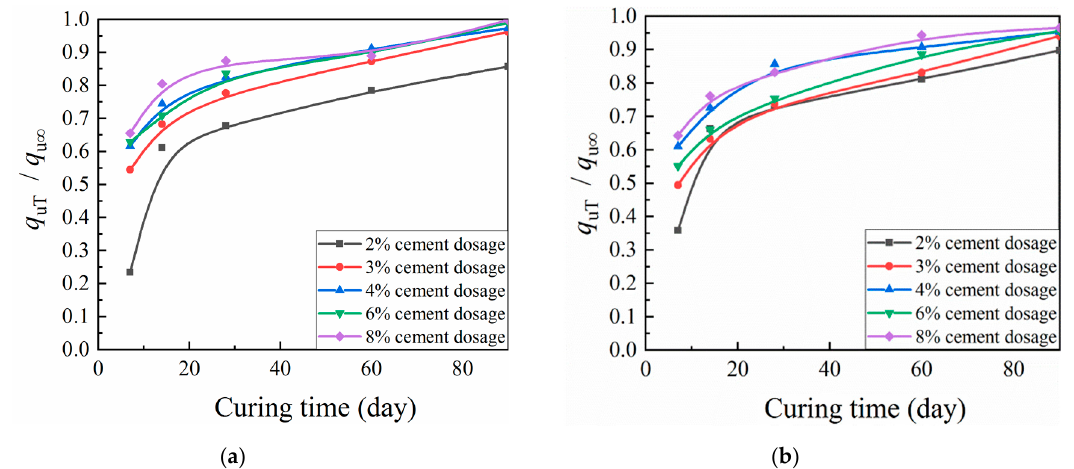
Figure 10. Relationship between q u T / q u ∞ and curing time of cement-modified loess (CML): ( a ) compaction coefficient K = 0.92; and ( b ) K = 0.95.